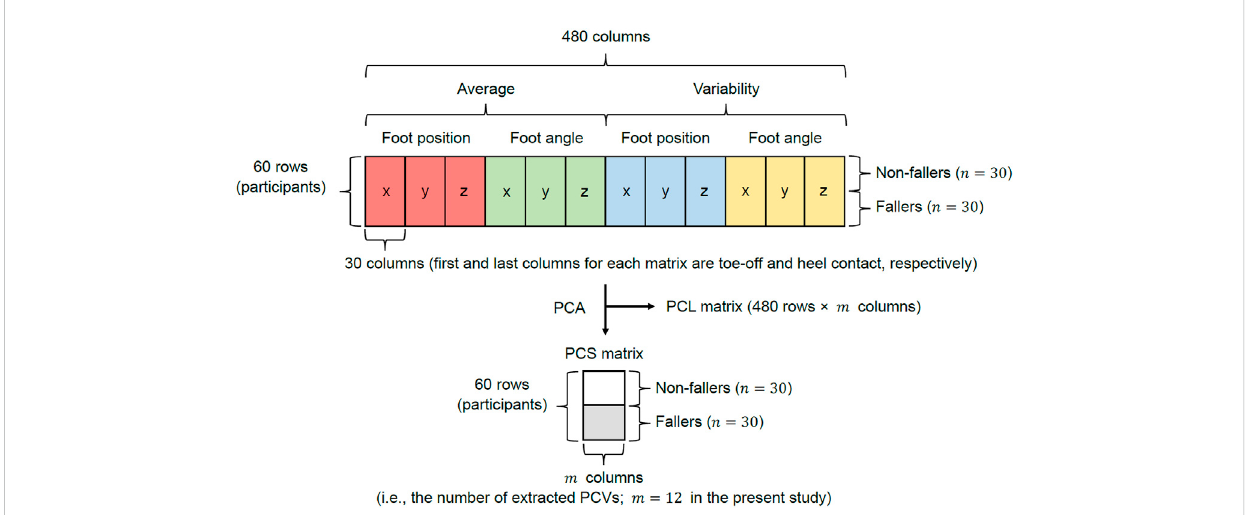
FIGURE 2 Explanation of the matrix used for PCA. The red, green, blue, and yellow matrices for each axis represent the average foot position, average foot angle, variability in foot position, and variability in foot angle,